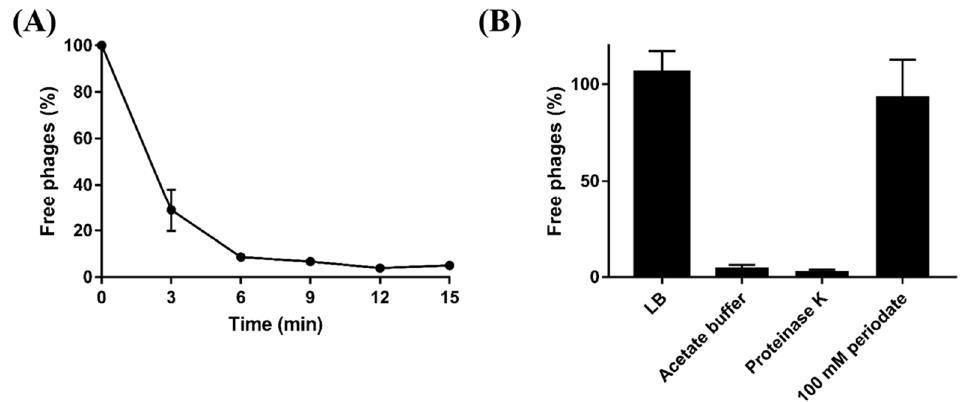
Figure 3. Adsorption assay of BECP10. ( A ) BECP10 adsorption assay against E. coli NCTC 12079 at 37 °C for 15 min. ( B ) Effect of periodate and proteinase K treatments on the adsorption efficiency of BECP10. The LB broth in BECP10 was considered as 100% (control) and the free phage rate was determined after incubation for 15 min at 37 °C.